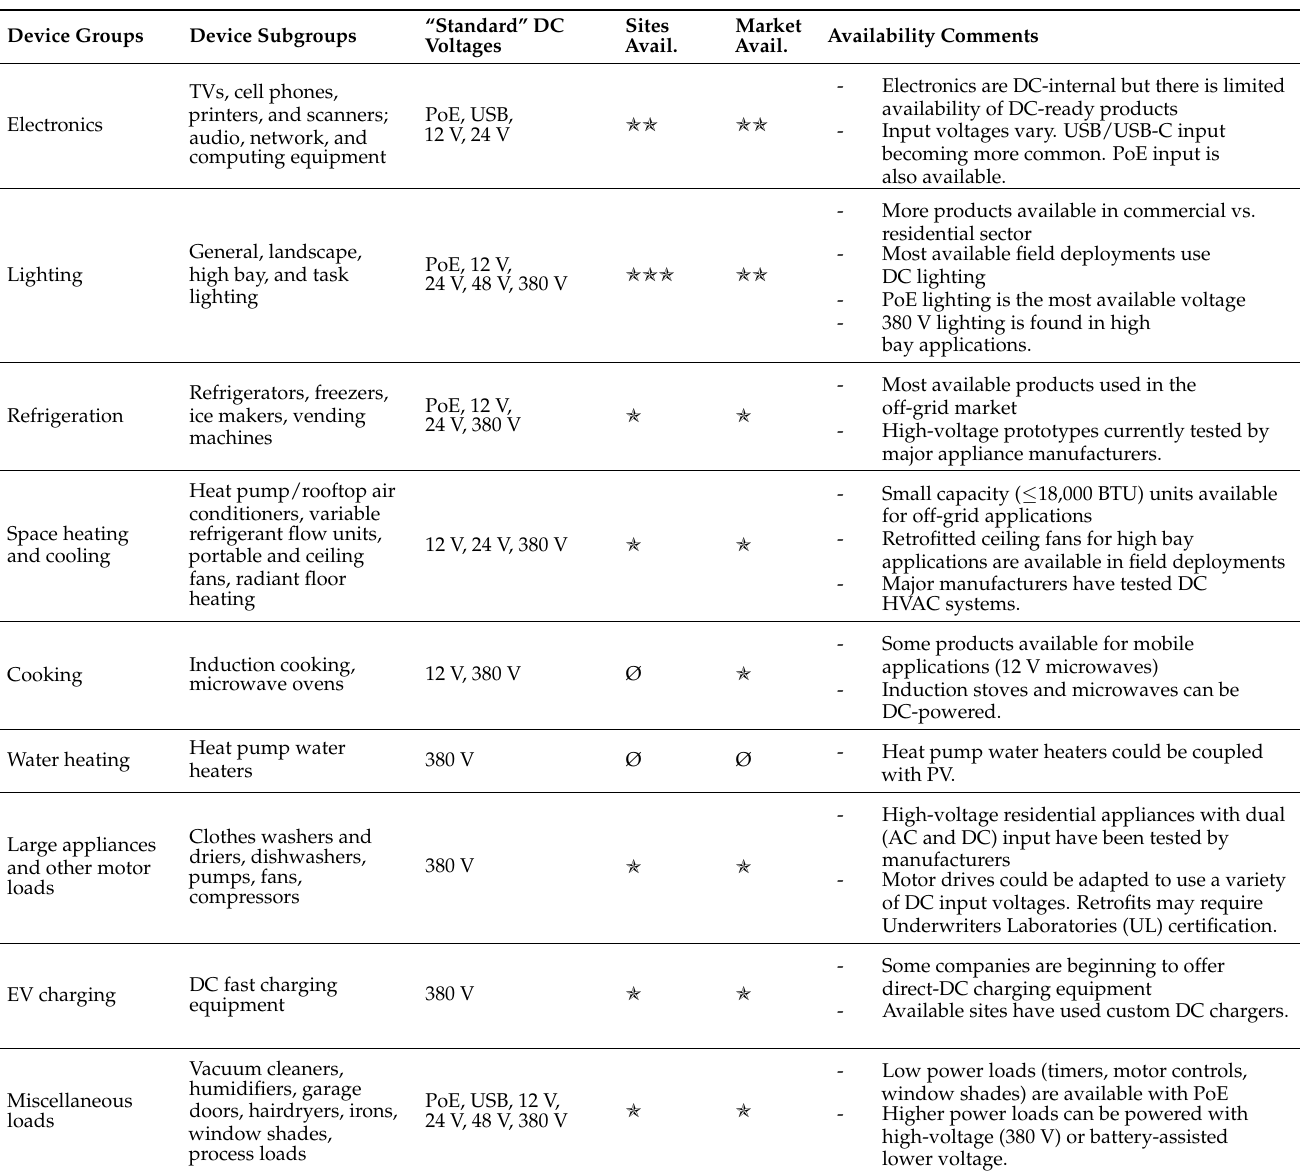
Table 3. Availability of DC-ready